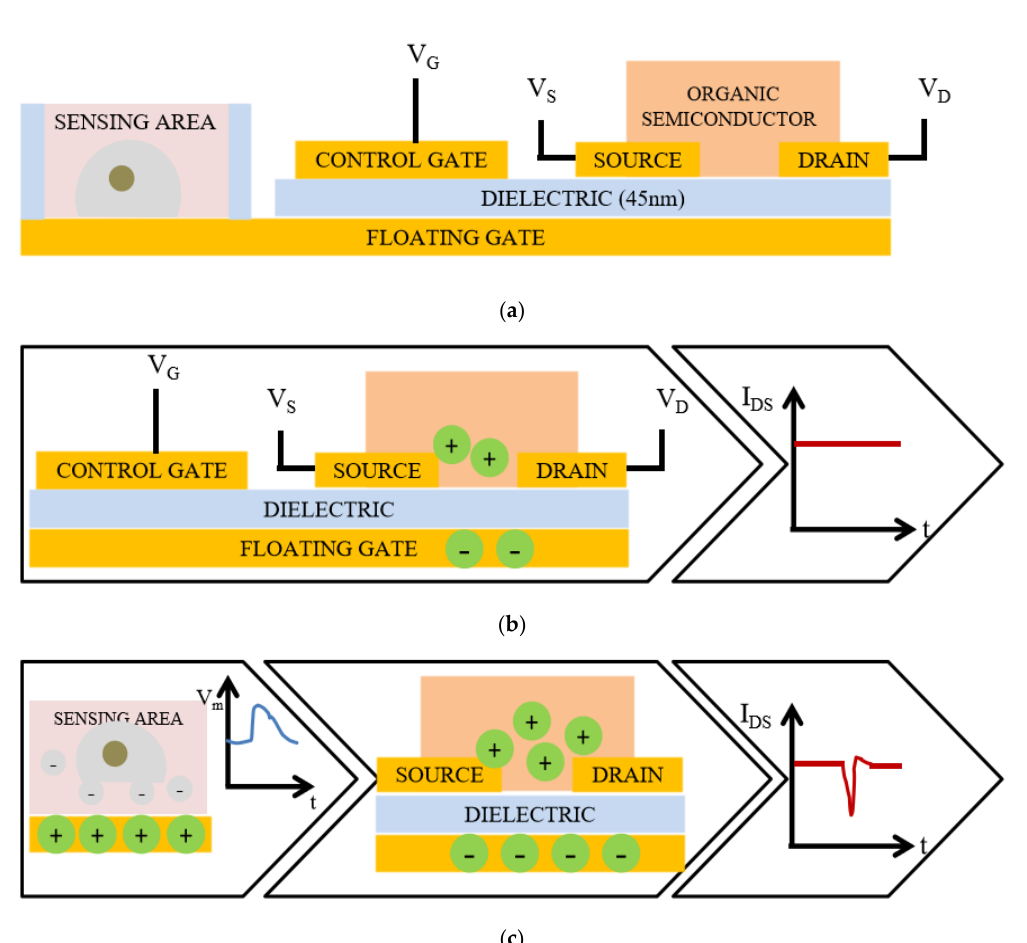
Figure 1. Working principle of a floating gate organic charge-modulated field-effect transistor (OCMFET). ( a ) Cross section of the device, where the floating gate is exposed to the surrounding bioelectrochemical environment as the sensing area. ( b ) The setting of the working point by applying the appropriate V G . ( c ) The charge sensing and modulation principle of the device, where the charge variations occurring in close proximity to the sensing area cause a charge separation in the floating gate, which leads to modulation of the charge carrier density inside the channel of the transistor and variation of the output current.